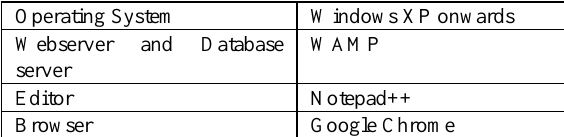
Table 5. Software